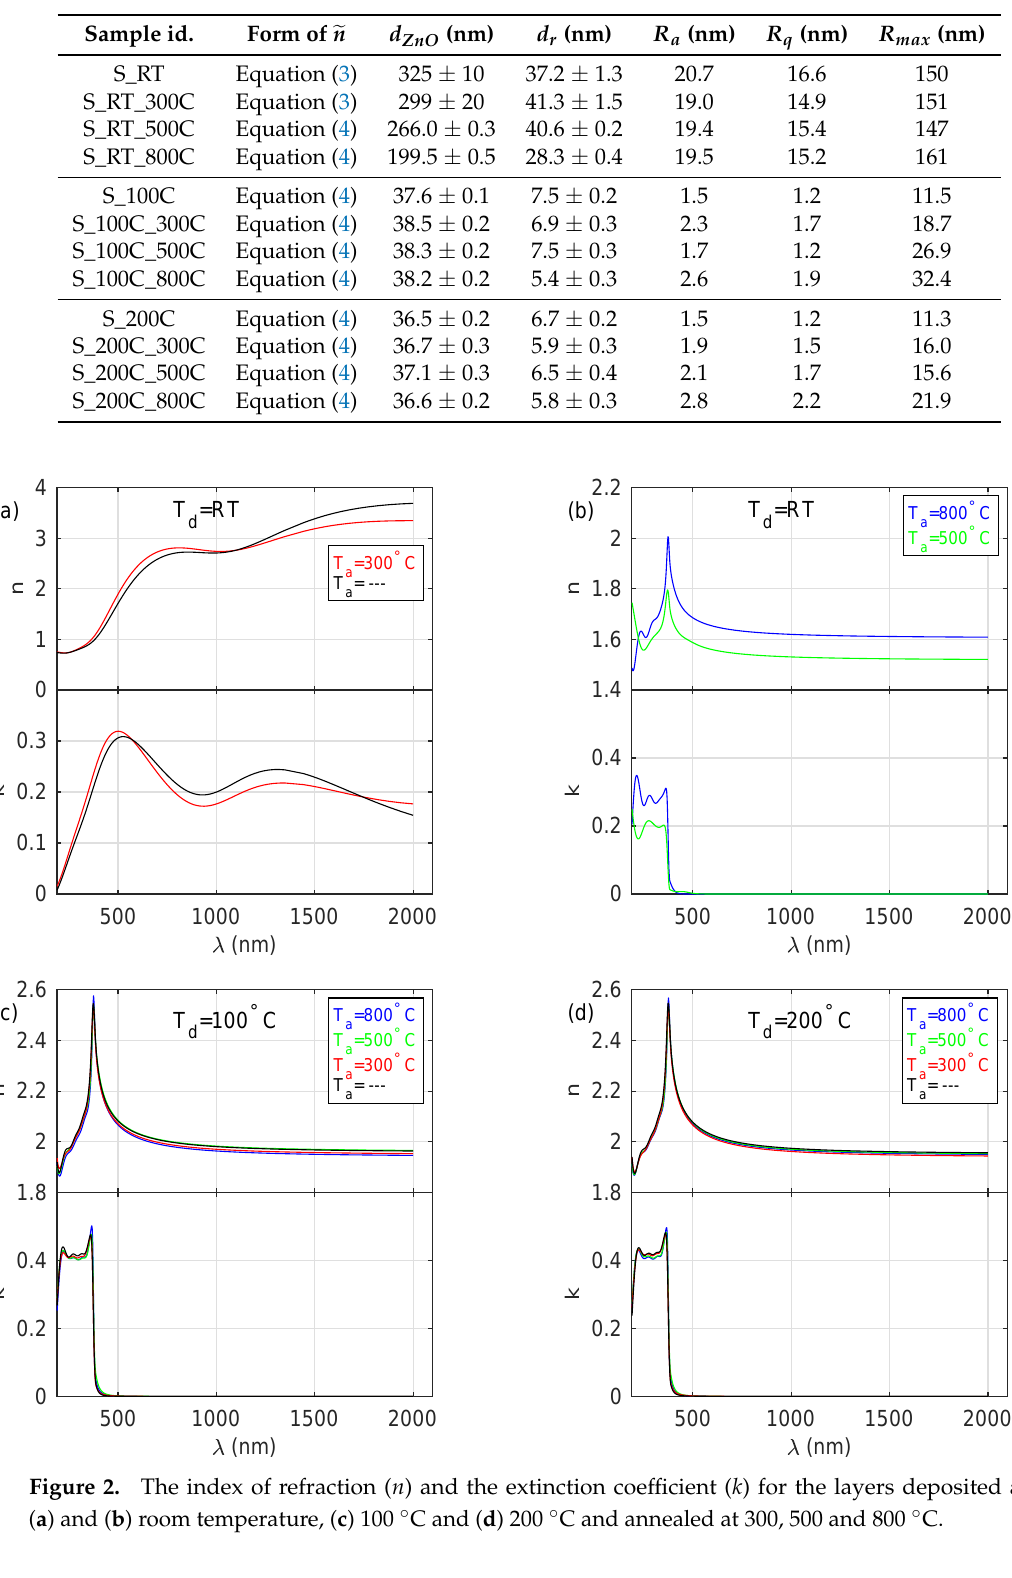
Table 2. The form of the complex refractive index used to parametrise optical constants of the produced films, thicknesses of ZnO ( d ZnO ) and rough ( d r ) layers as well as roughness parameters ( R a , R q and R max ) determined for the investigated samples.